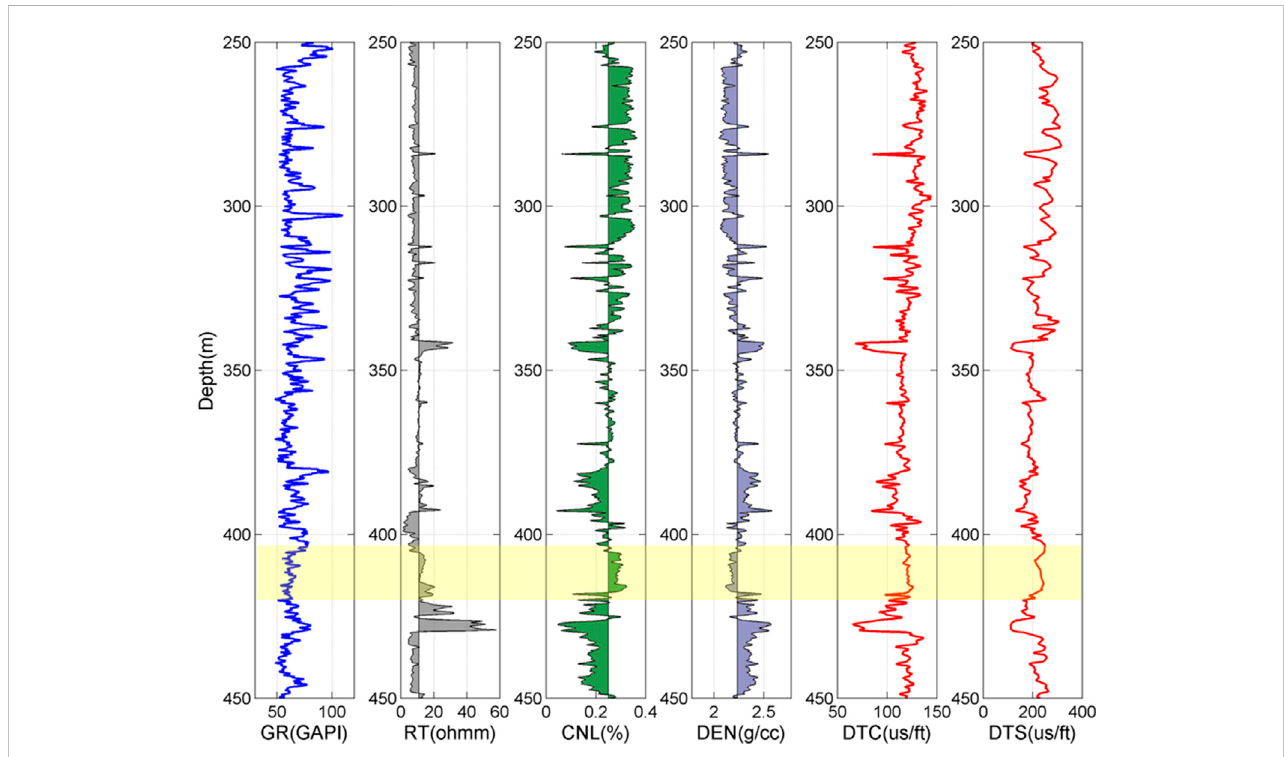
FIGURE 2 Well logs of well #1 from Fengcheng oil fi eld. GR means gamma ray log; RT means resistivity log; CNL means compensated neutron log; DEN means density log; DTC means compressional wave slowness log; DTS means shear wave slowness log; and the yellow section marks the target